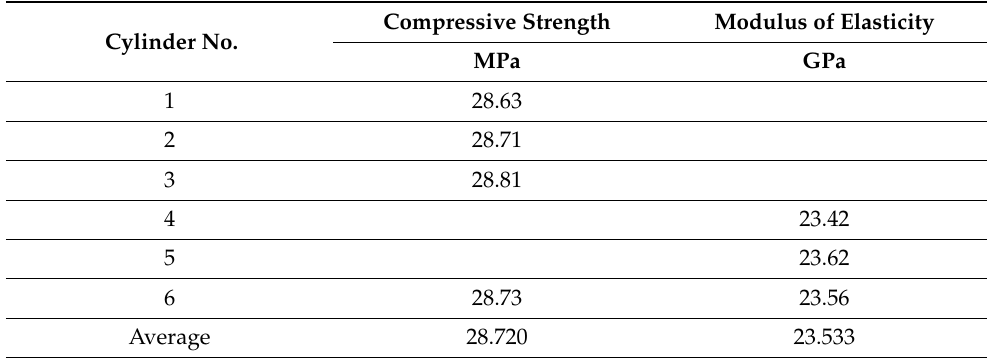
Table 5. Experimental results of compressive stress and modulus of elasticity. Cylinder